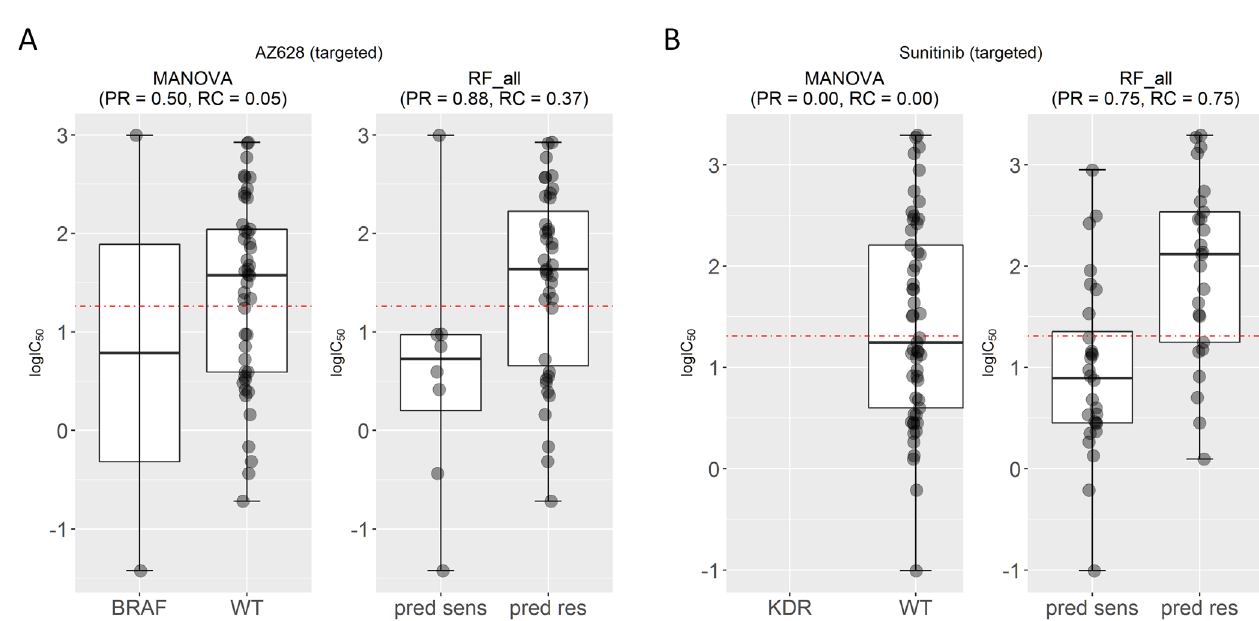
Figure 3. Examples of drugs for which transcriptomic markers predict their cell line sensitivity with better precision than that of single-gene markers on the test set. ( A ) Test set precision obtained by the AZD628-BRAF marker is moderate (PR=0.50) despite being a strong drug-gene association (P=3∙10 -15 ). By contrast, the multi-gene marker for AZD628 achieves a substantially higher precision (PR=0.88). ( B ) The sunitinib-Kinase Insert Domain Receptor (KDR) association (P=0.0002) offers no precision in the test set, since none of the test cell lines harbour mutations in the KDR gene. By contrast, the transcriptomic marker achieves a much higher precision (PR=0.75). Interestingly, both multi-gene markers achieve much better recall (RC=0.37 for AZD628 and RC=0.75 for sunitinib) than their corresponding single- gene markers (RC=0.05 and RC=0.00), which means that a substantially higher proportion of sensitive cell lines are correctly predicted as sensitive.